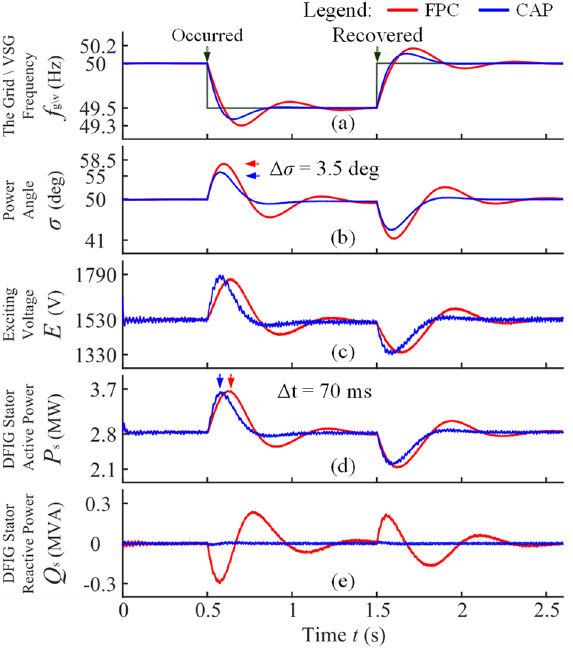
Figure 10. Inertial operational waveforms of a DFIG-VSG at the rated wind speed: ( a – e ) The frequency, power angle, exciting voltage, stator active power and stator reactive power of the DFIG- VSG.